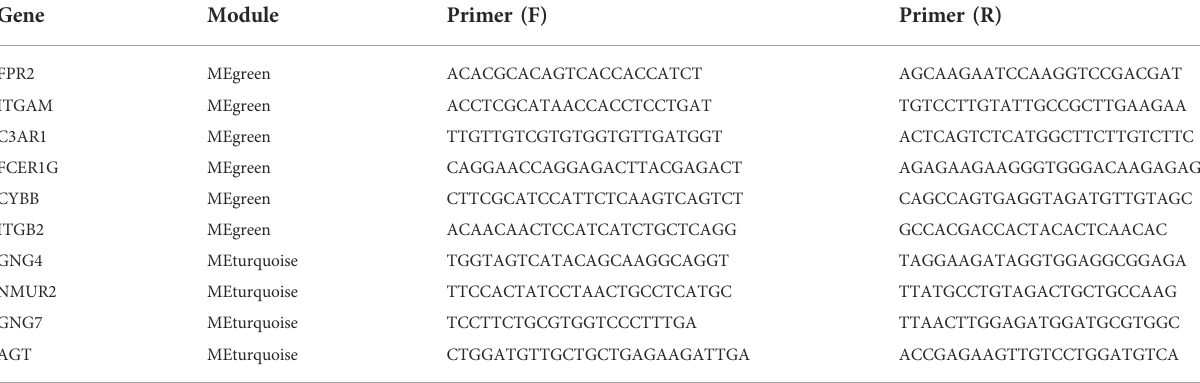
TABLE 1 The genes and primers used for experimental validation by qRT-PCR.